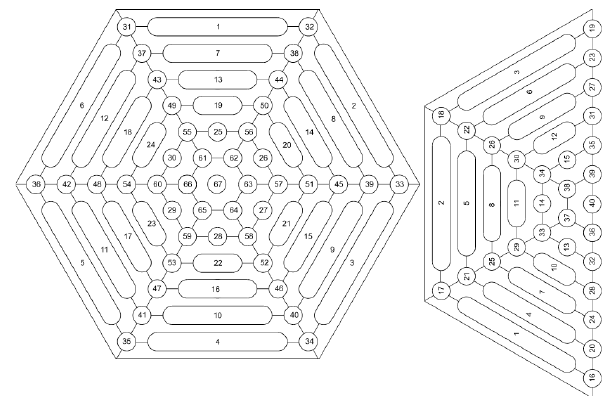
Figure 5. Illustration of WWER-440 fuel assembly models with fuel rod numbering. Outer fuel rods are merged to simplify the model, fuel rods with poten- tially higher PCT are modeled individually.